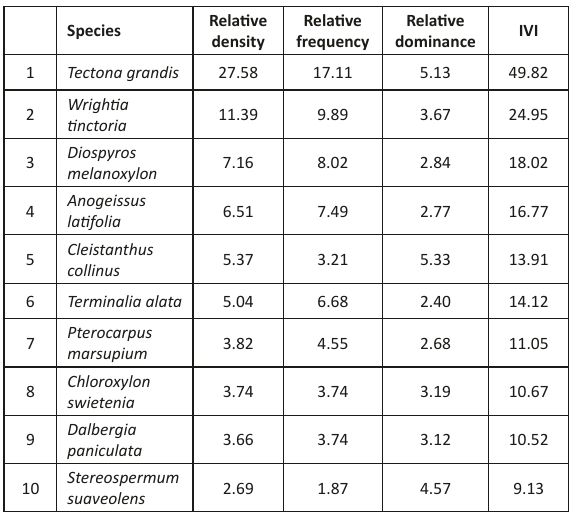
Table 1. Analysis of seedlings.